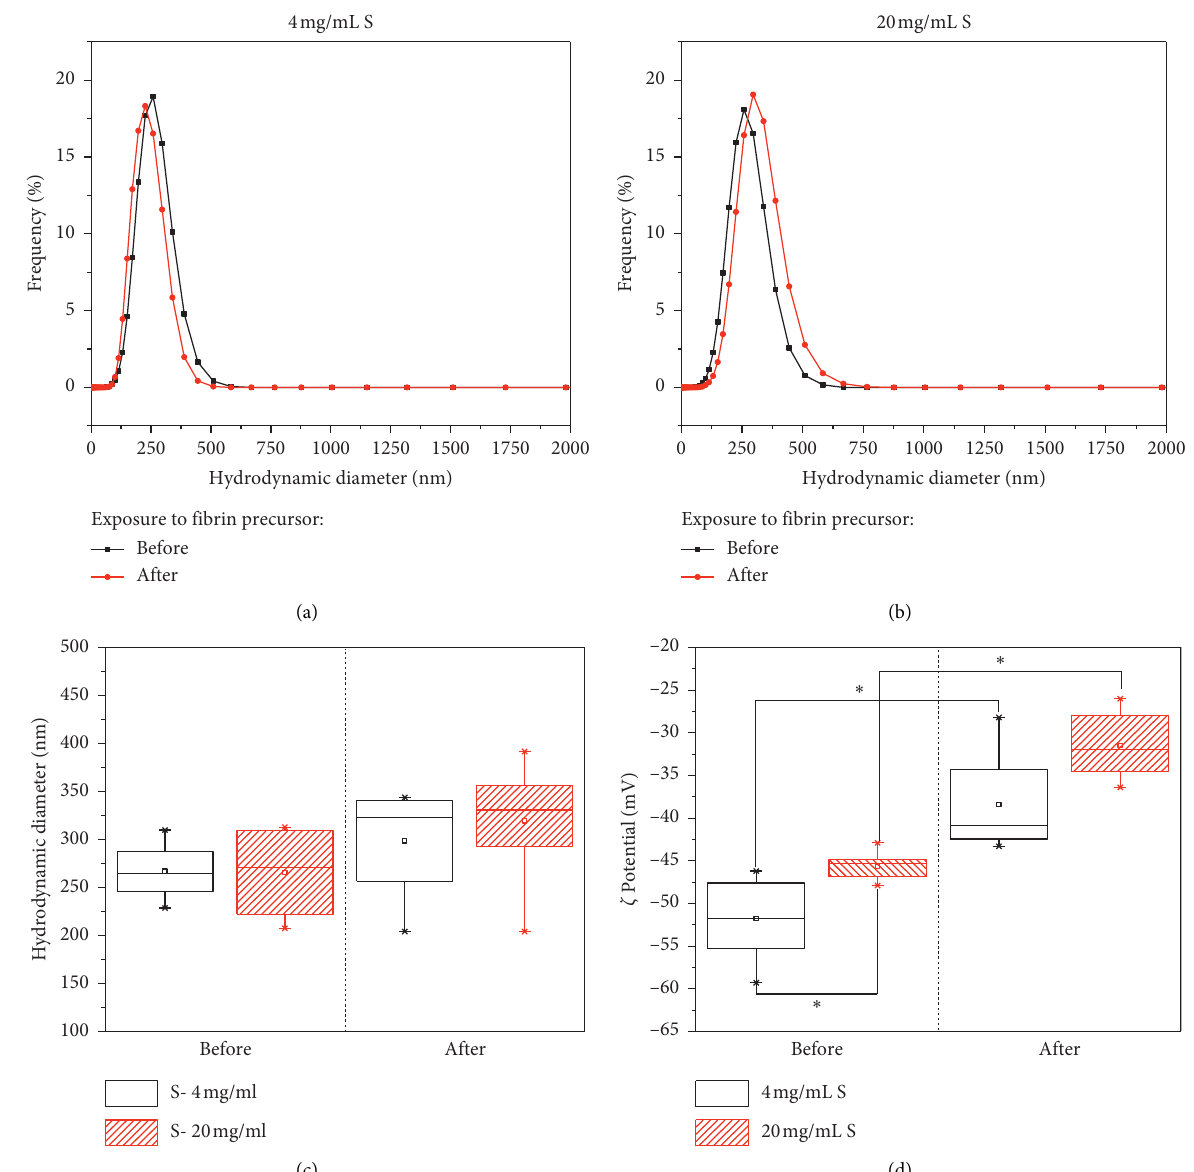
Figure 1: Silica (S) colloidal properties. Hydrodynamic diameter size: distribution for 4mg/mL S (a) and 20 mg/mL S (b) changes after exposure to the fibrin precursor (c) measured by Dynamic Light Scattering (DLS) and ζ -potential results (d). ∗ Different at a significance level of 0.005 for n �